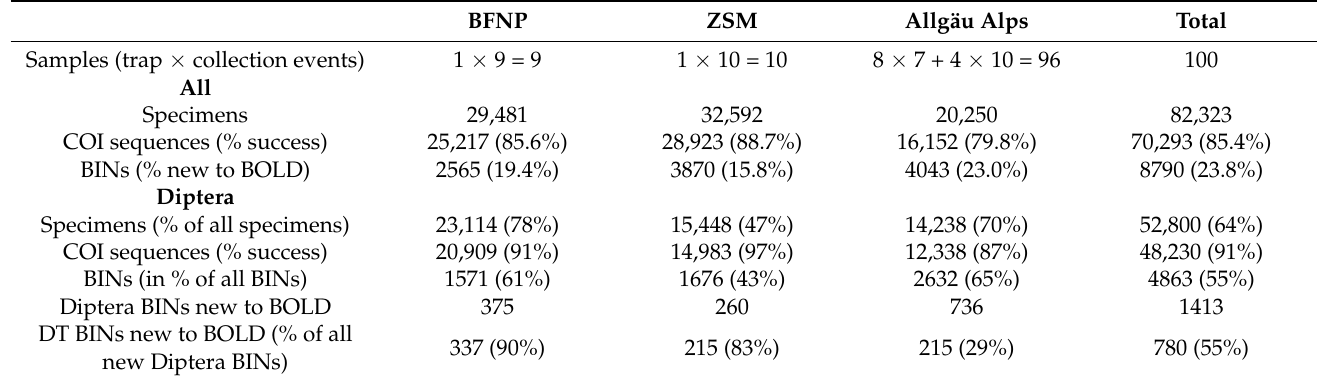
Table 3. Sequence results for the three sampling sites. Total sample size, number of